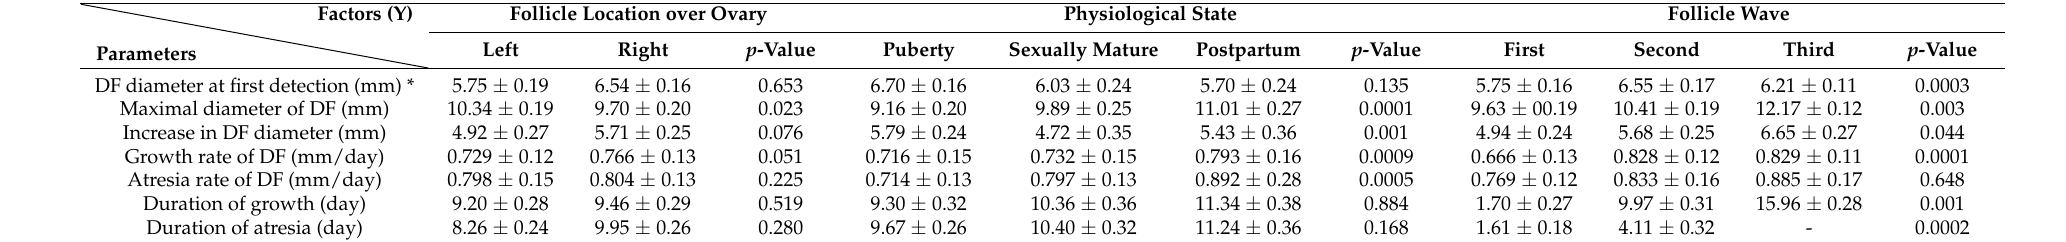
Table 5. Comparison of follicle location on ovary, physiological stage and number of follicle waves on follicular dynamics of crossbred Chinese buffaloes during estrous